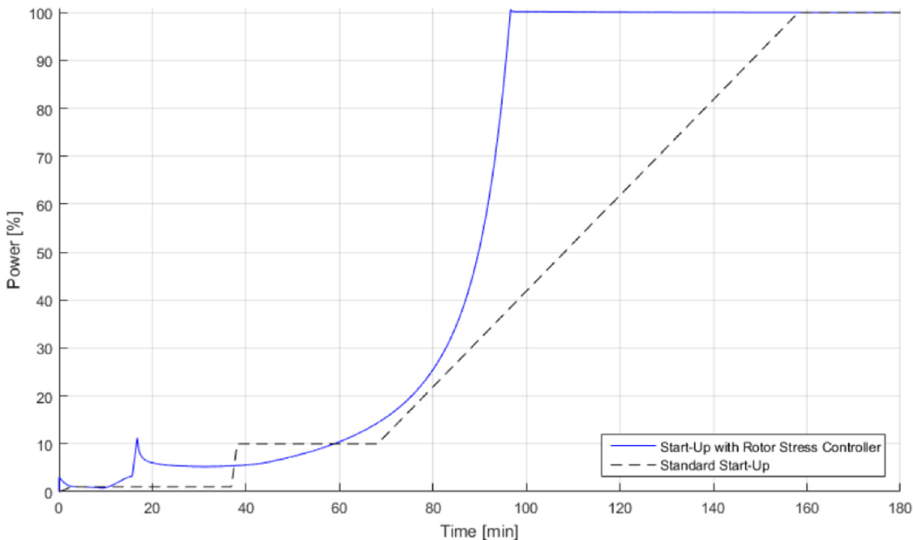
Figure 6. Performance of PI-based Rotor Stress Controller.